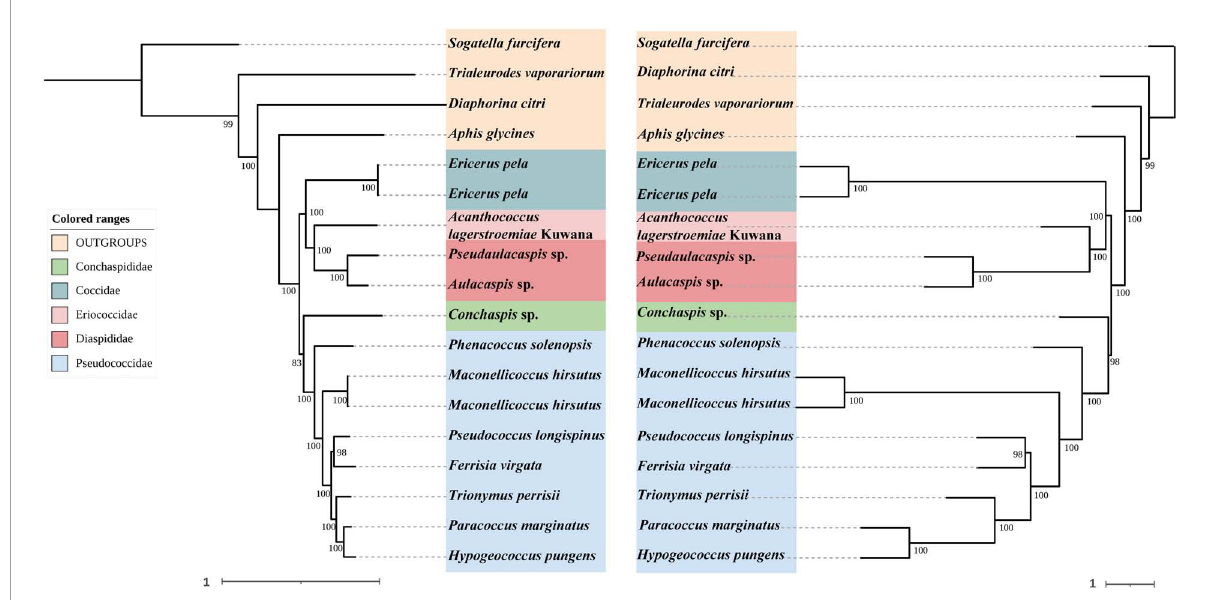
FIGURE5 Left: Concatenated tree of 75% completeness matrices from Hemiptera probe set. Node values are bootstrap support. Right: Species tree of 75% completeness matrices from Hemiptera probe set. Node values are bootstrap support.